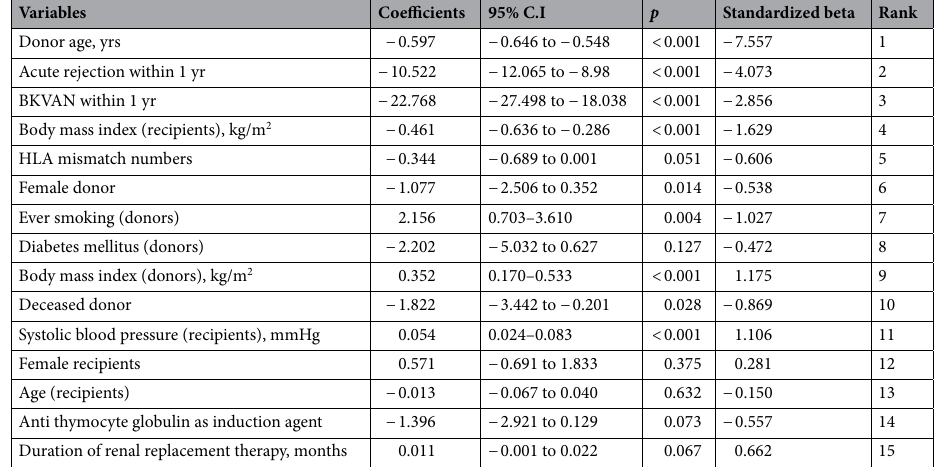
Table 6. Selected predictors to post-transplant 1 year estimated glomerular filtration rate and dominance. BKVAN, BK virus associated nephropathy; HLA, human leukocyte antigen.